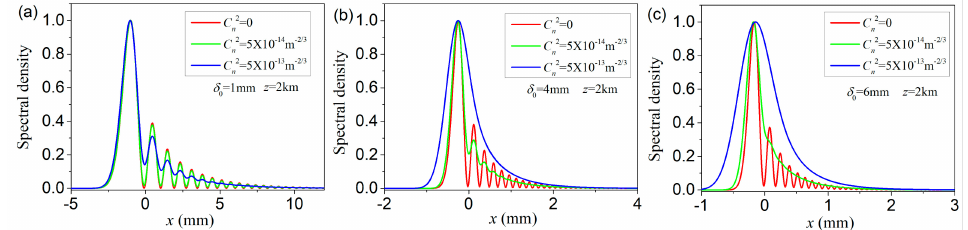
Figure 4. Normalized 1D spectral density of the MCLGC beam in turbulence with three different coherence widths at a propagation distance of 2 km. ( a – c ) The beam coherence widths are δ 0 = 1.0 mm, 4.0 mm and 6.0 mm, respectively.